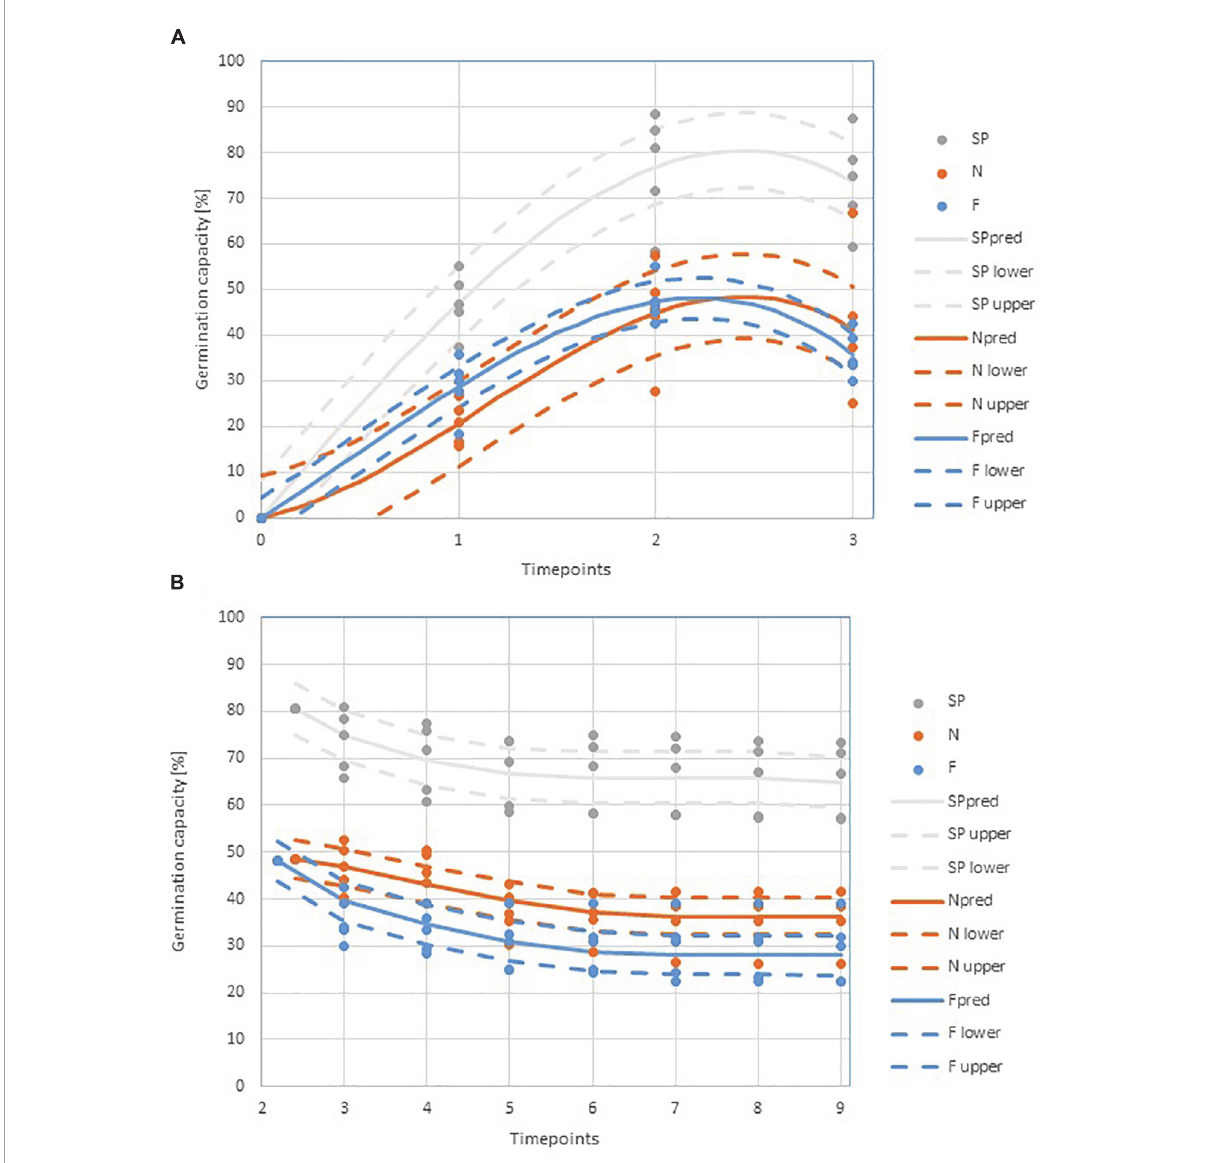
FIGURE2 Germination dynamics of the tested pine seeds (A) from the beginning of the experiment to the peak of germination (B) and from the peak of germination to the end of the experiment in the studied variants (SP, F, N) at selected timepoints: 0 (planting) to 30 April; 1–24 May; 2–7 June; 3–18 June; 4–28 June; 5–12 July; 6–2 August; 7–22 August; 8–6 September; 9–end of